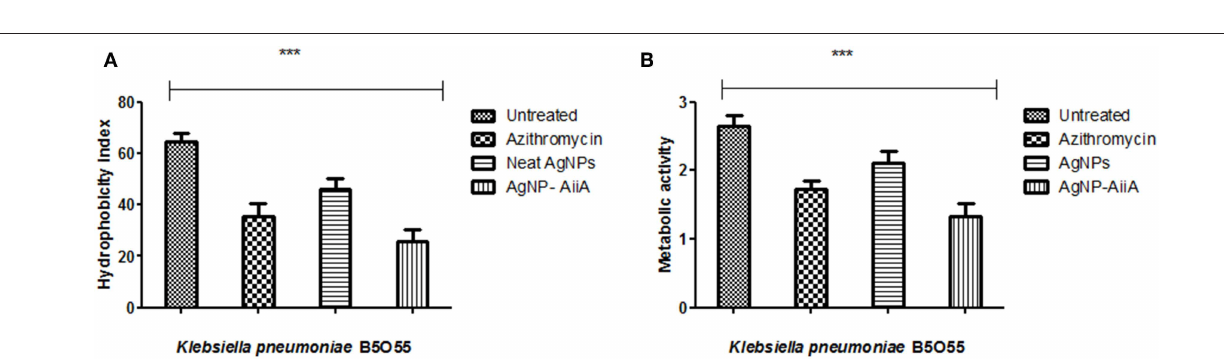
of combination therapy reduced EPS production by 50.48